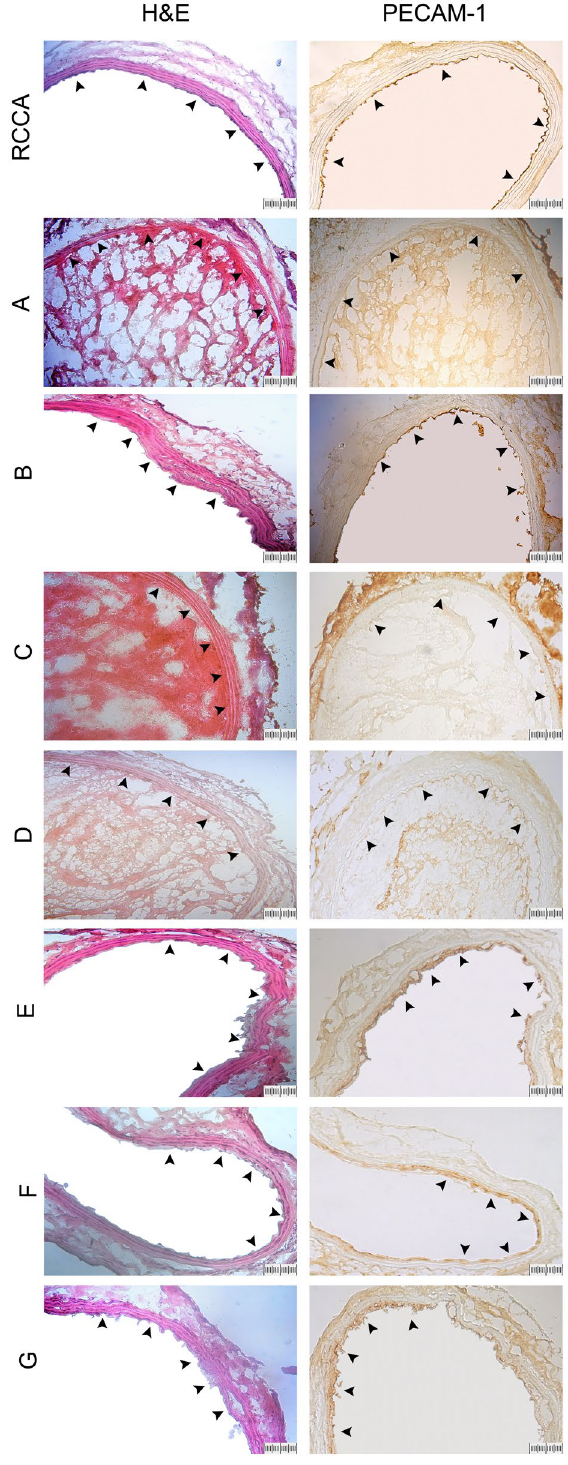
Figure 4. Hematoxylin and eosin (H&E) staining and platelet endothelial cell adhesion molecule-1 (PECAM- 1) immunostaining at 7d in each treatment group. The H&E staining shows normal architecture of vessel wall in right CCA (RCCA), and PECAM-1 immunoreactivity is continuously distributed in the endothelium of luminal wall in right CCA. However, in the left CCA of groups A, C and D, the thrombus is present inside the lumen, and the PECAM-1 immunoreactivity is remarkably reduced and distributed discontinuously. In the left CCA of groups B, E, F and G, the thrombus is less present inside the lumen, and the PECAM-1 immunoreactivity is remarkably visible and distributed less discontinuously compared to groups A, C and D. Groups E, F and G show a better endothelial distribution at the luminal wall than groups A, C and D. Arrows indicate the luminal wall of